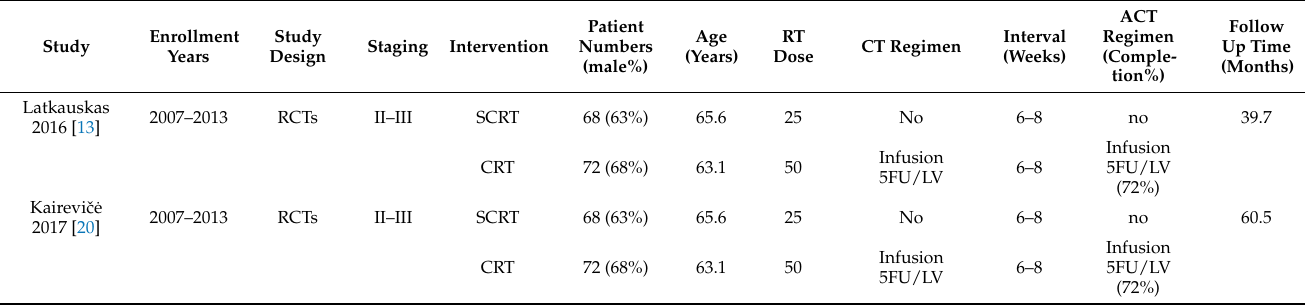
Table 1. Summary of the characteristics of the included